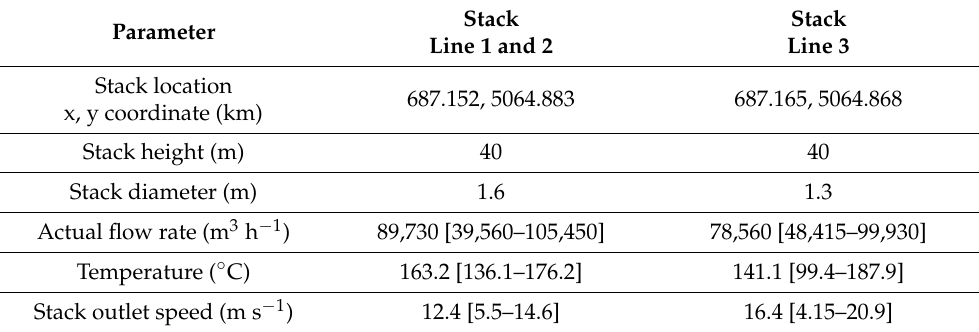
Table 1. Stack locations and geometric features (UTM32-WGS84 coordinates, height, diameter), and mean and min–max range (square brackets) for the atmospheric release conditions (hourly flow rate, temperature, outlet